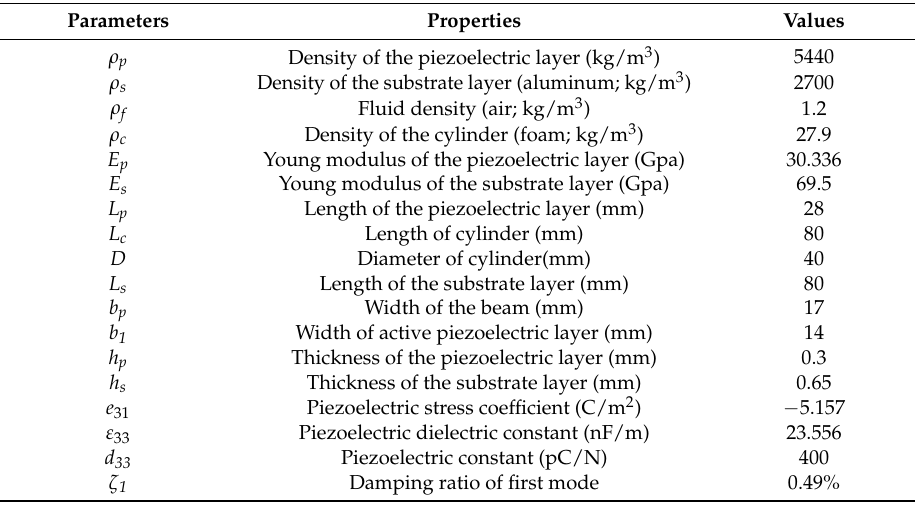
Table 1. The geometric and physical properties of energy harvesting